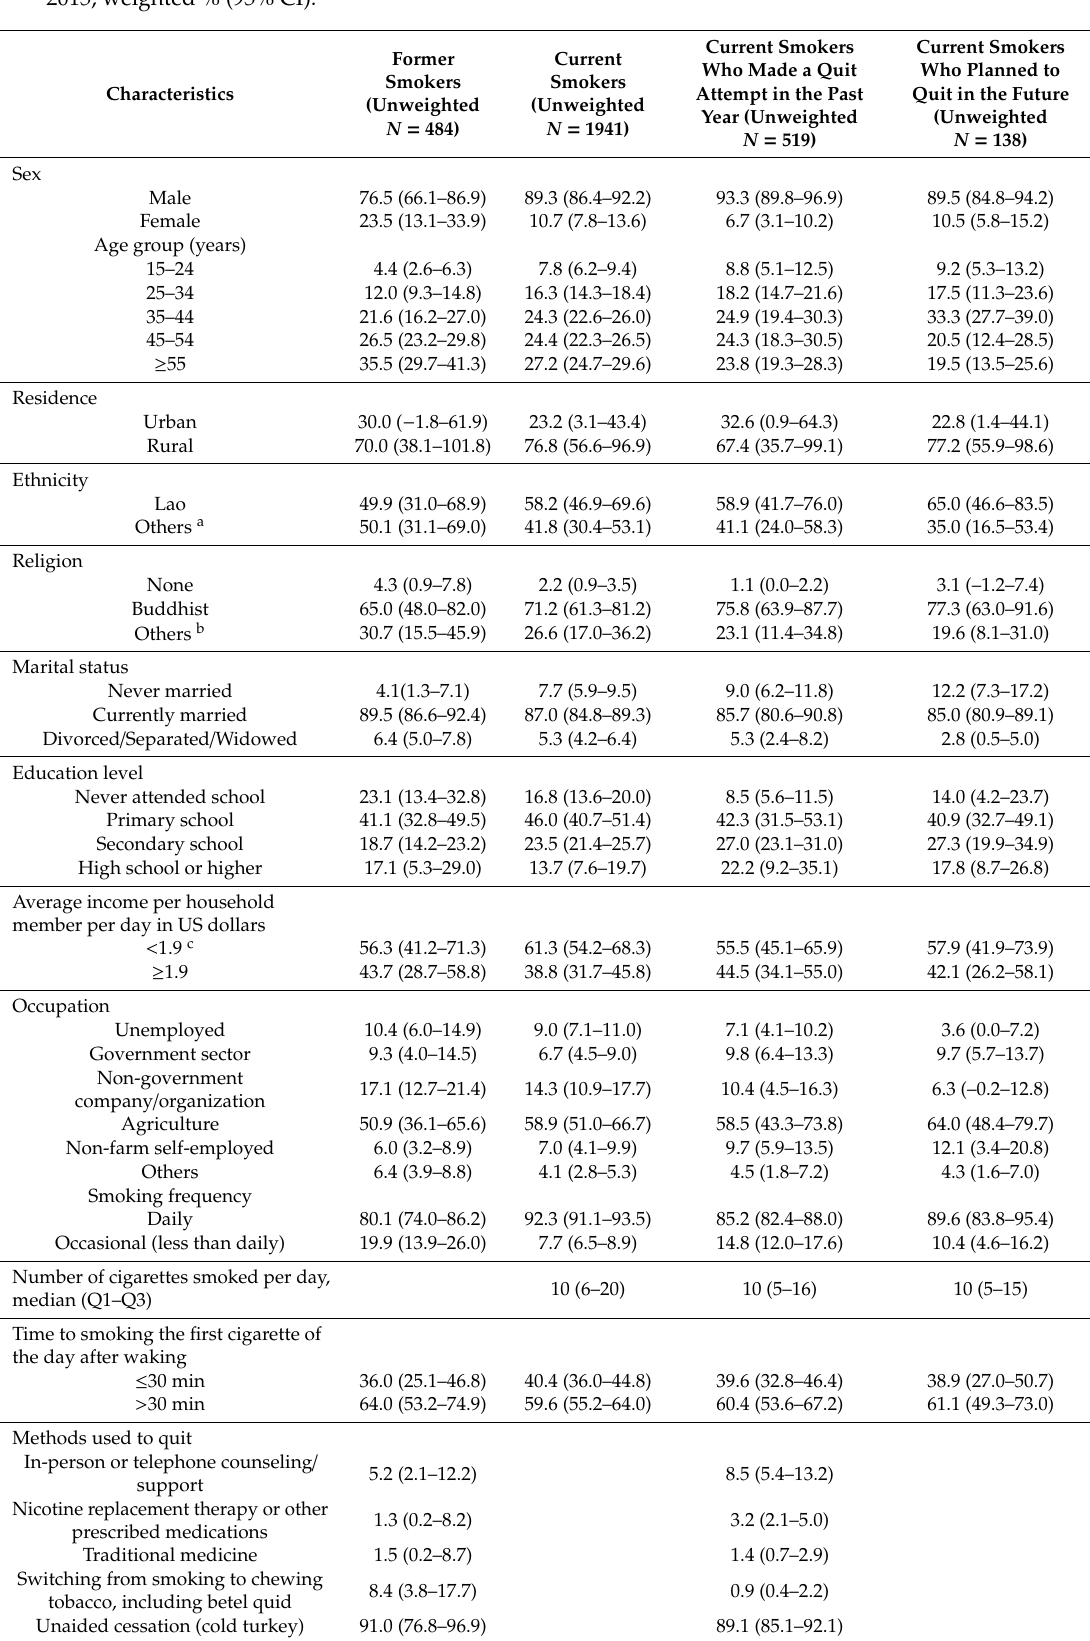
Table 1. Demographic characteristics of adult cigarette smokers, Lao People’s Democratic Republic, 2015, weighted % (95%